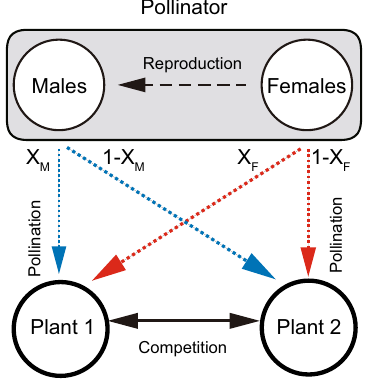
Figure 1. Conceptual illustration of the model analysed in this study. The two competing plants are pollinated by one pollinator species in which male and female pollinators have sex-specific visiting preferences on the two plants. Only female pollinators reproduce offspring. X M and X F are sex-specific visitation frequencies on plant